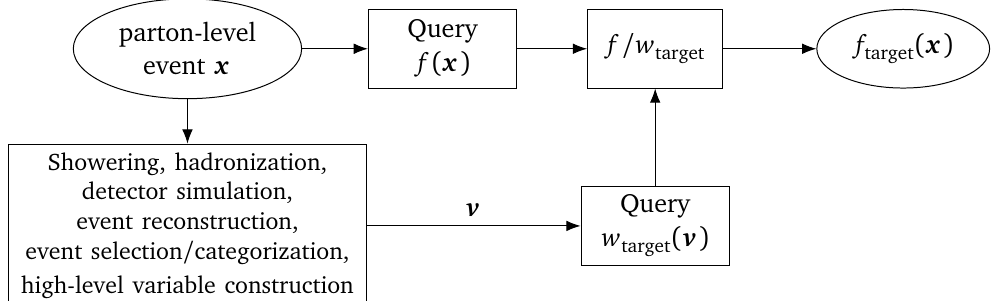
Figure 9: A flowchart of the oracle for f discussed in Section 3.2.2. The query for f ( x ) can be performed with the existing standard HEP machinery, while the query for w trained in Section